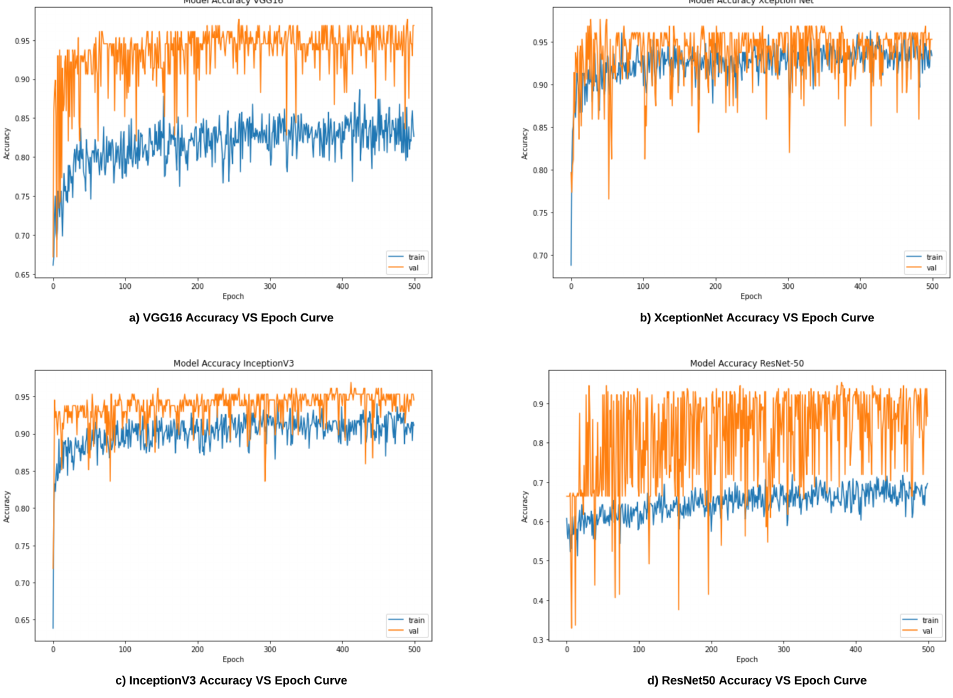
Figure 8. Accuracy vs. Epoch curves for the base